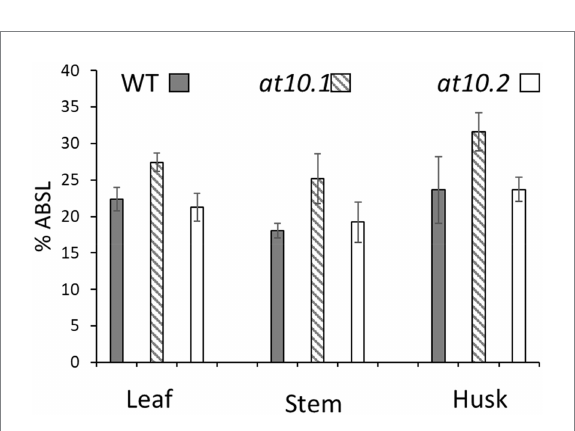
FIGURE 6 Acetyl bromide soluble lignin analysis. The lignin content of WT (Gray bars), Osat10.1 (Hatched bars), Osat10.2 (White bars) as mass % acetyl bromide soluble lignin. The bars indicate the standard errors. Student’s t-test was run between WT and both mutants to check for